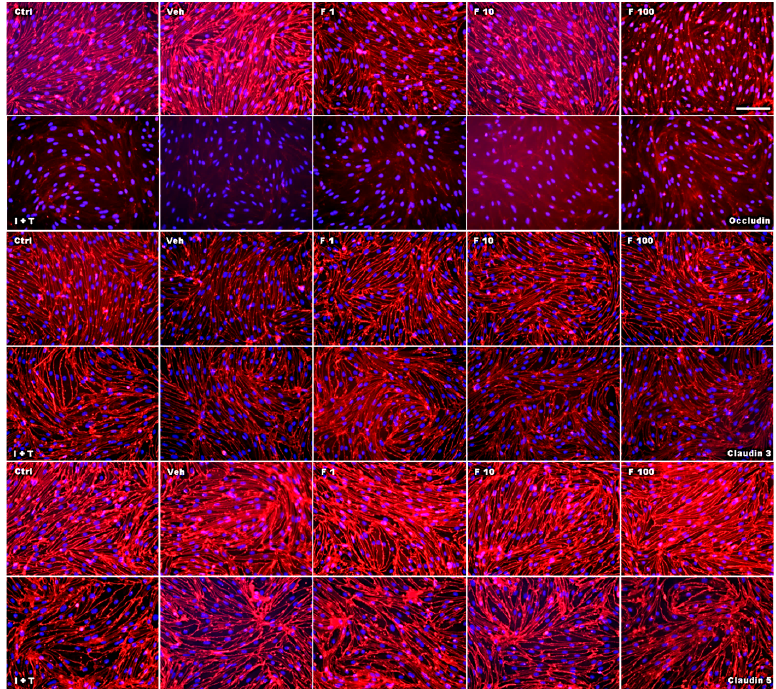
Figure 6. Effect of fullerenol on the distribution of the junctional proteins in mouse brain microvascular endothelial cell (MBMEC) cultures under basal and inflammatory conditions. Immunofluorescence images of tight junction molecules (red) counterstained with Hoechst (blue) in MBMEC treated with fullerenols (F 1, 1 µg/mL; F 10, 10 µg/mL; F 100, 100 µg/mL) for 18 h under basal or inflammatory (I + T; 100 IU each) conditions. Scale bar (100 µm) counts for all immunofluorescence images. Ctrl, untreated control; Veh, vehicle treatment.